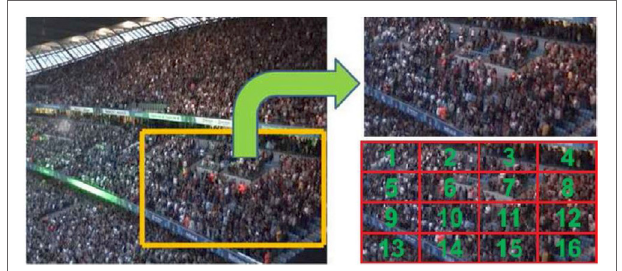
FiGURe 5 | The analyzed portion of the grandstand and 16 regions of interest. Reprinted from (Jones et al., 2011b) with permisson from